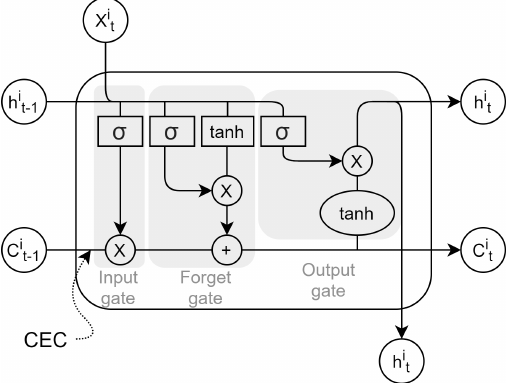
Figure 3. Block diagram of an LSTM cell.